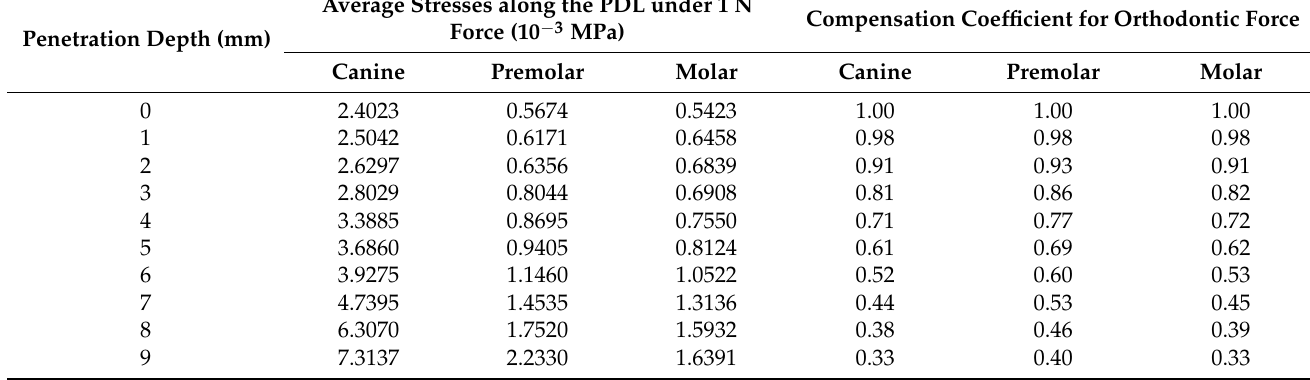
Table 5. Stress levels and force compensation coefficients for bodily tooth